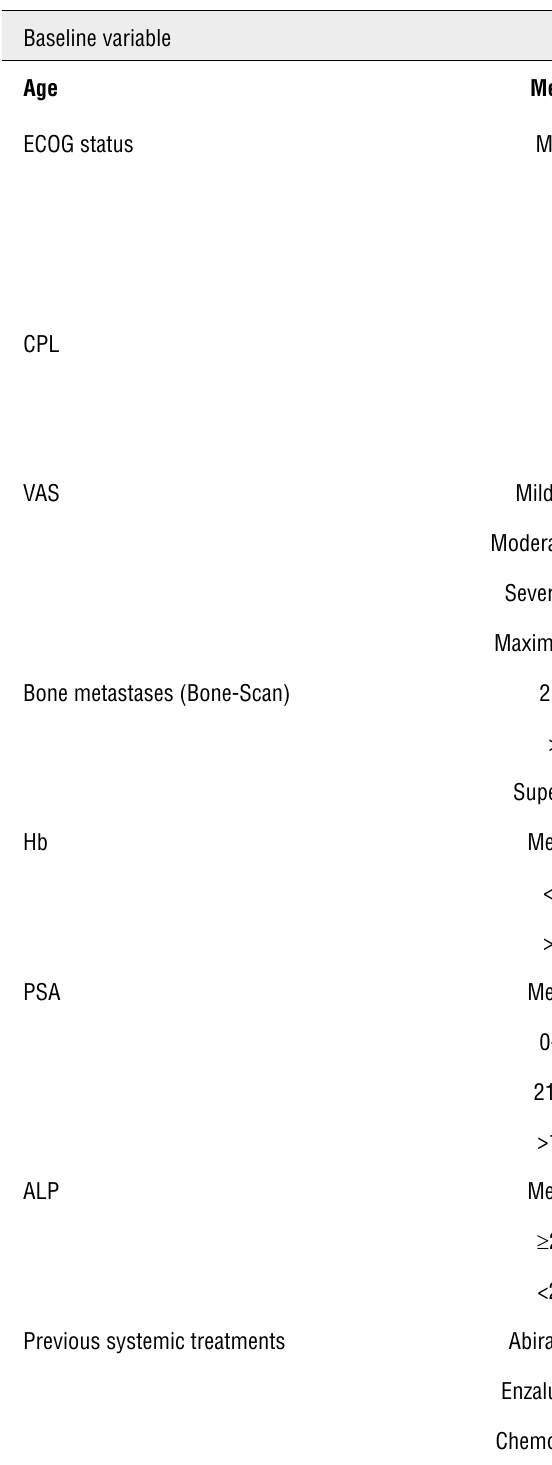
Table 3 - Baseline patients’